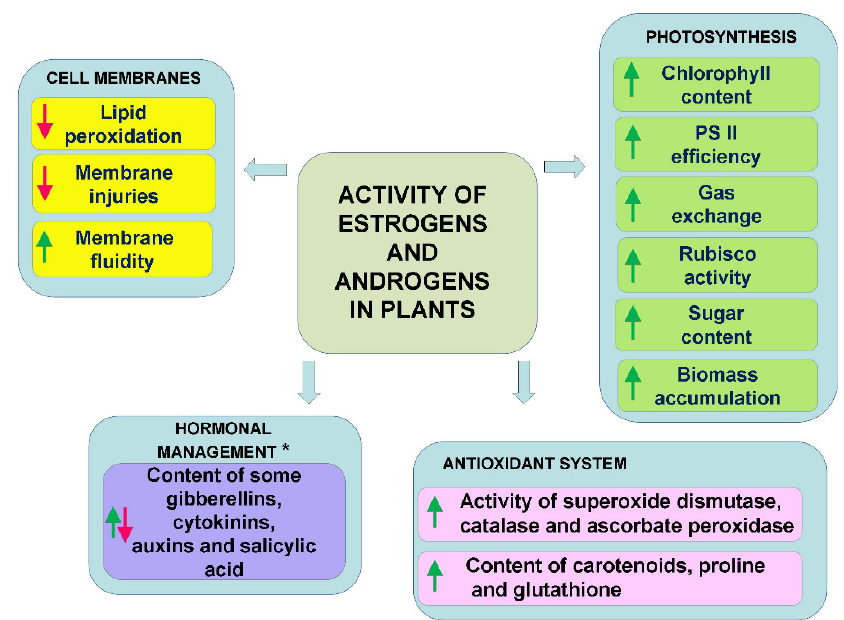
Figure 2. General directions of activity of estrogens and androgens (applied at low concentrations) in plants exposed to abiotic stresses. *—For detailed information, see Section 3.2.1. Plant Stress Re- sponse, which noted the dependency on plant organ (aerial part, roots) and time of exposition to stress factors.